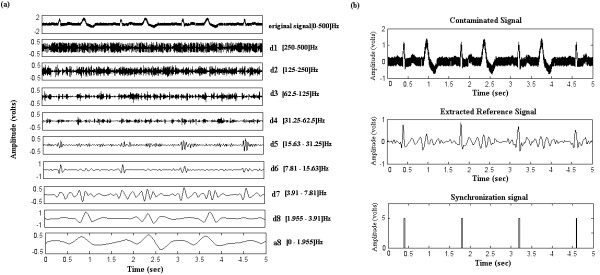
Processing example of a simulated pathological ECG. (a)Decomposition into sub-bands of a "Bigeminy" signal contaminated by the GE sequence noise (b) Extraction of the reference and synchronization signals.